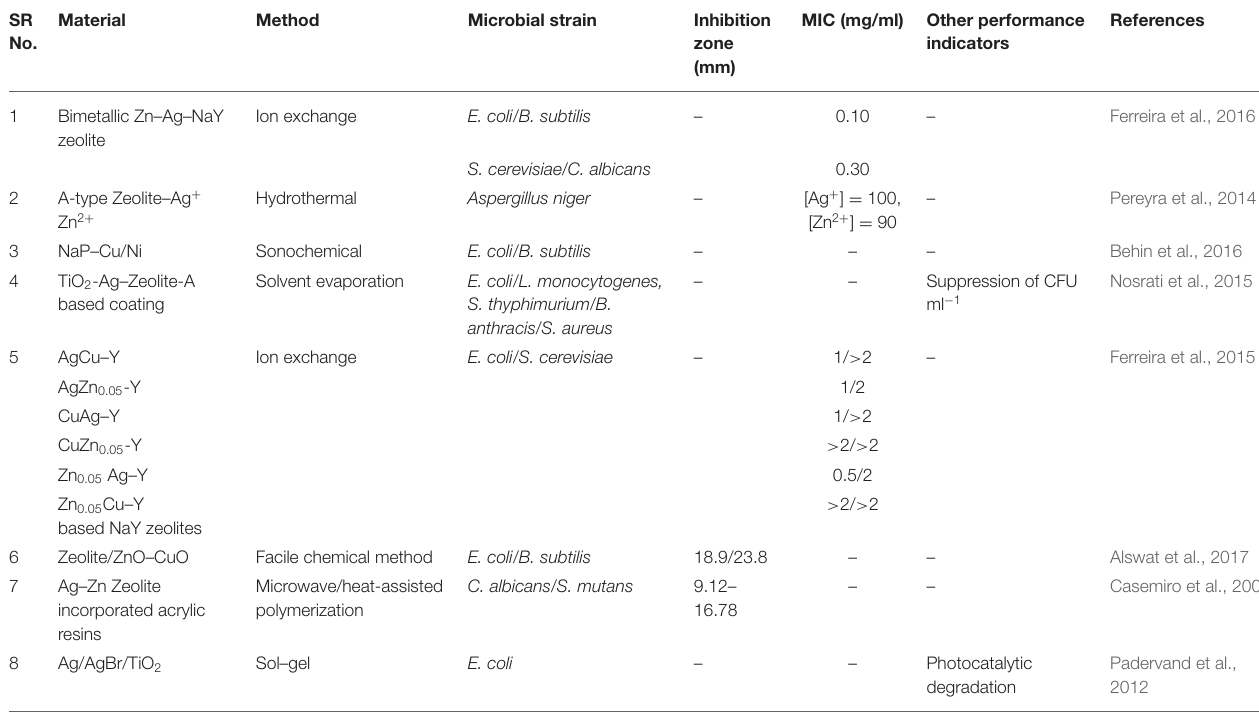
TABLE 1 | Types and antimicrobial properties of zeolite-supported bimetallic nanoparticles. SR No.